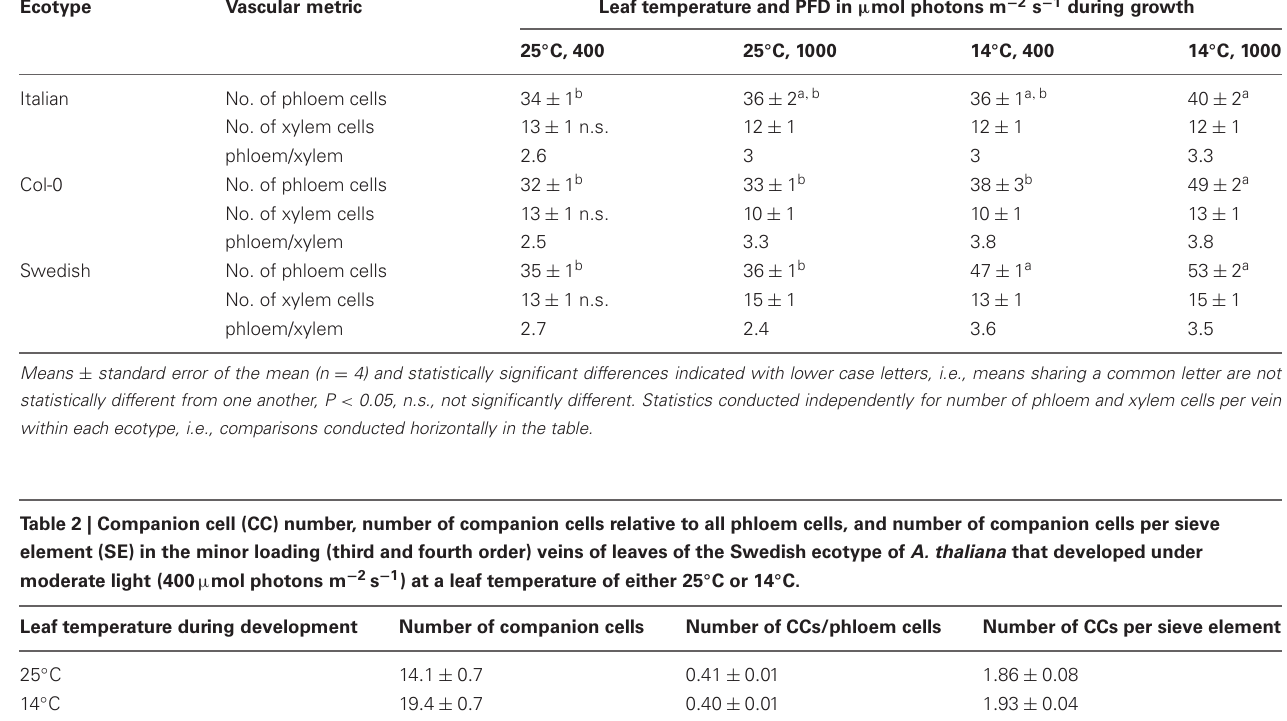
Leaf temperature during development Number of companion cells Number of CCs/phloem cells Number of CCs per sieve element 25 ◦ C 14 . 1 ± 0 . 7 0 . 41 ± 0 . 01 Level of significance P < 0 . 001 n.s. n.s. Means ± standard error of the mean (n = 4), n.s., not significantly different.